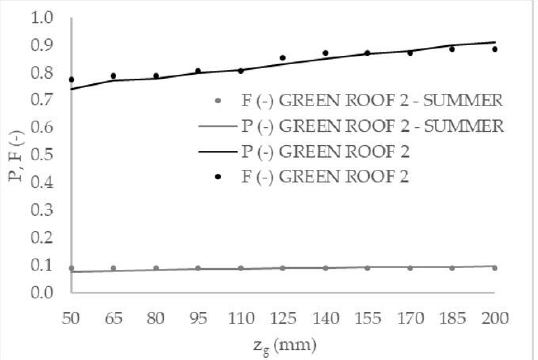
Figure 5. Probability ( P ) and frequency ( F ) distribution function of water content into growing medium varying its thickness ( z g ) during the whole year and summer, GREEN ROOF 2.